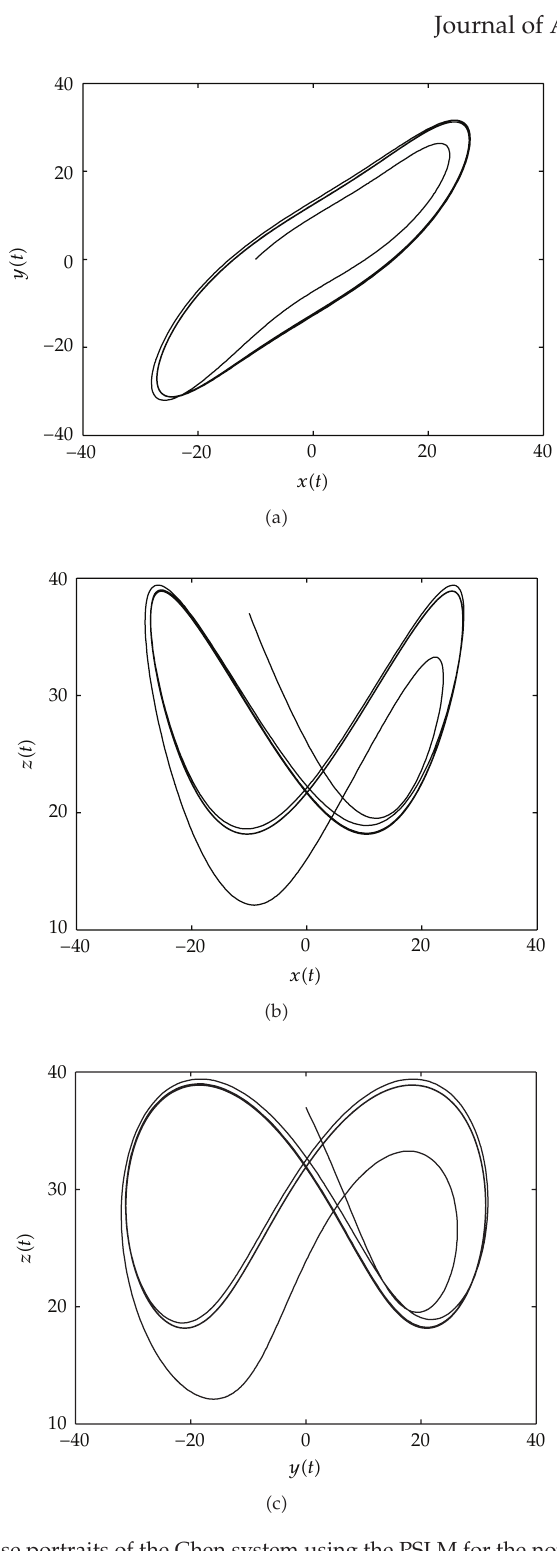
Figure 2: Phase portraits of the Chen system using the PSLM for the nonchaotic